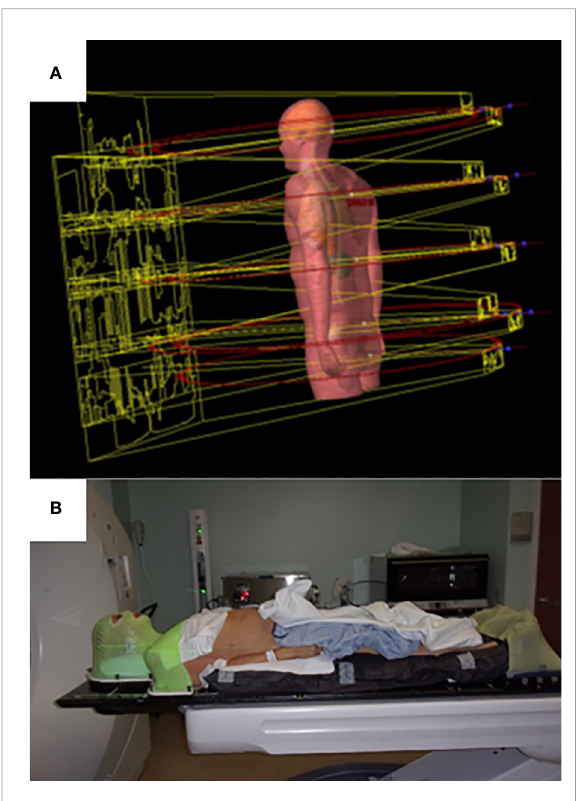
FIGURE 1 Upper body fi eld arrangement (A) and setup (B) for patient treated with VMAT